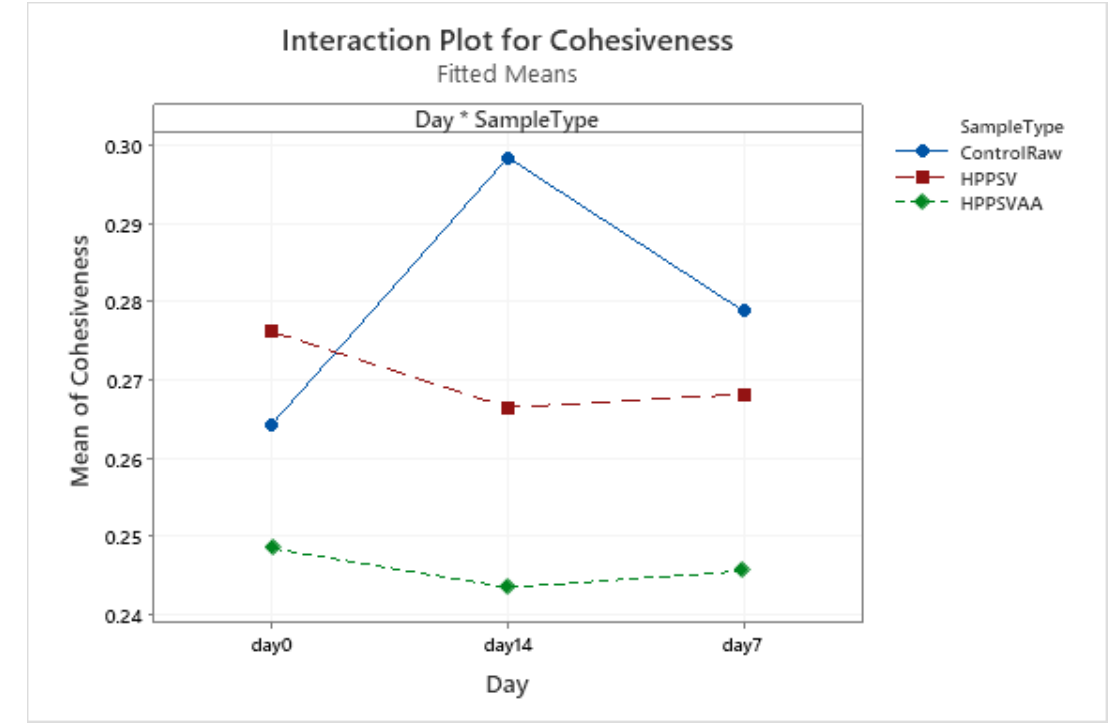
Figure A6 . Effect of treatments and storage time on the springiness of plant-based patty (HPPSV: HPP-SVCOOK).